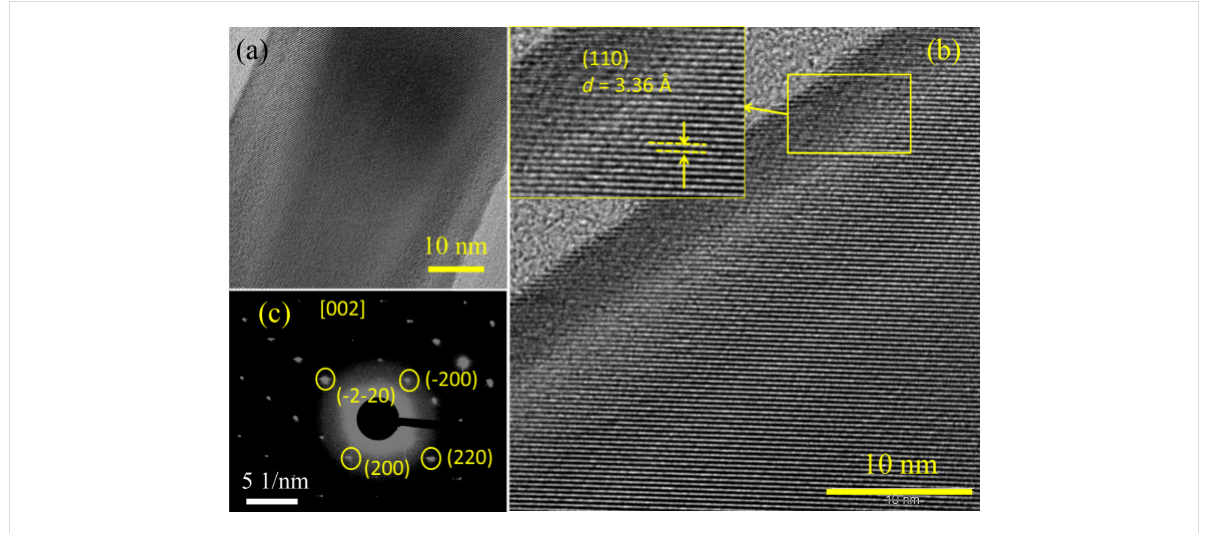
Figure 3: TEM images of cylindrical-shaped NWs. (a) HRTEM of NWs across the width. (b) HRTEM image of NWs. Inset shows the (110) plane of rutile SnO 2 . (c) SAED pattern of NWs obtained along the [002] zone axis.